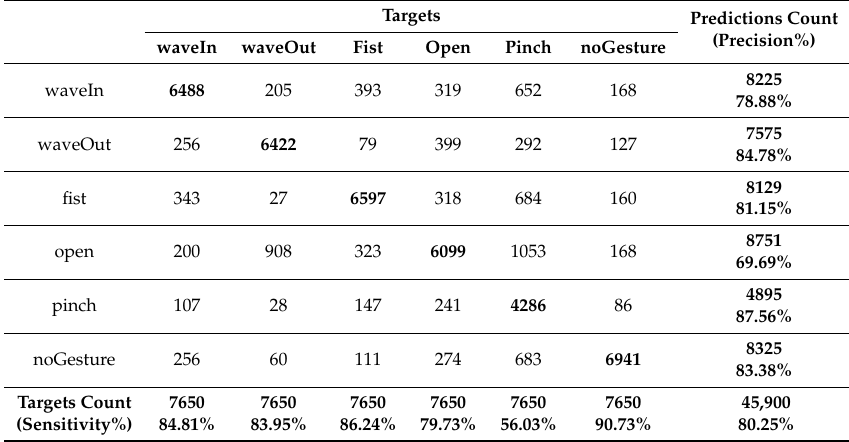
Table A13. Confusion matrix for experiment 3 . Synchronization gestures ( sync = 1 ) .